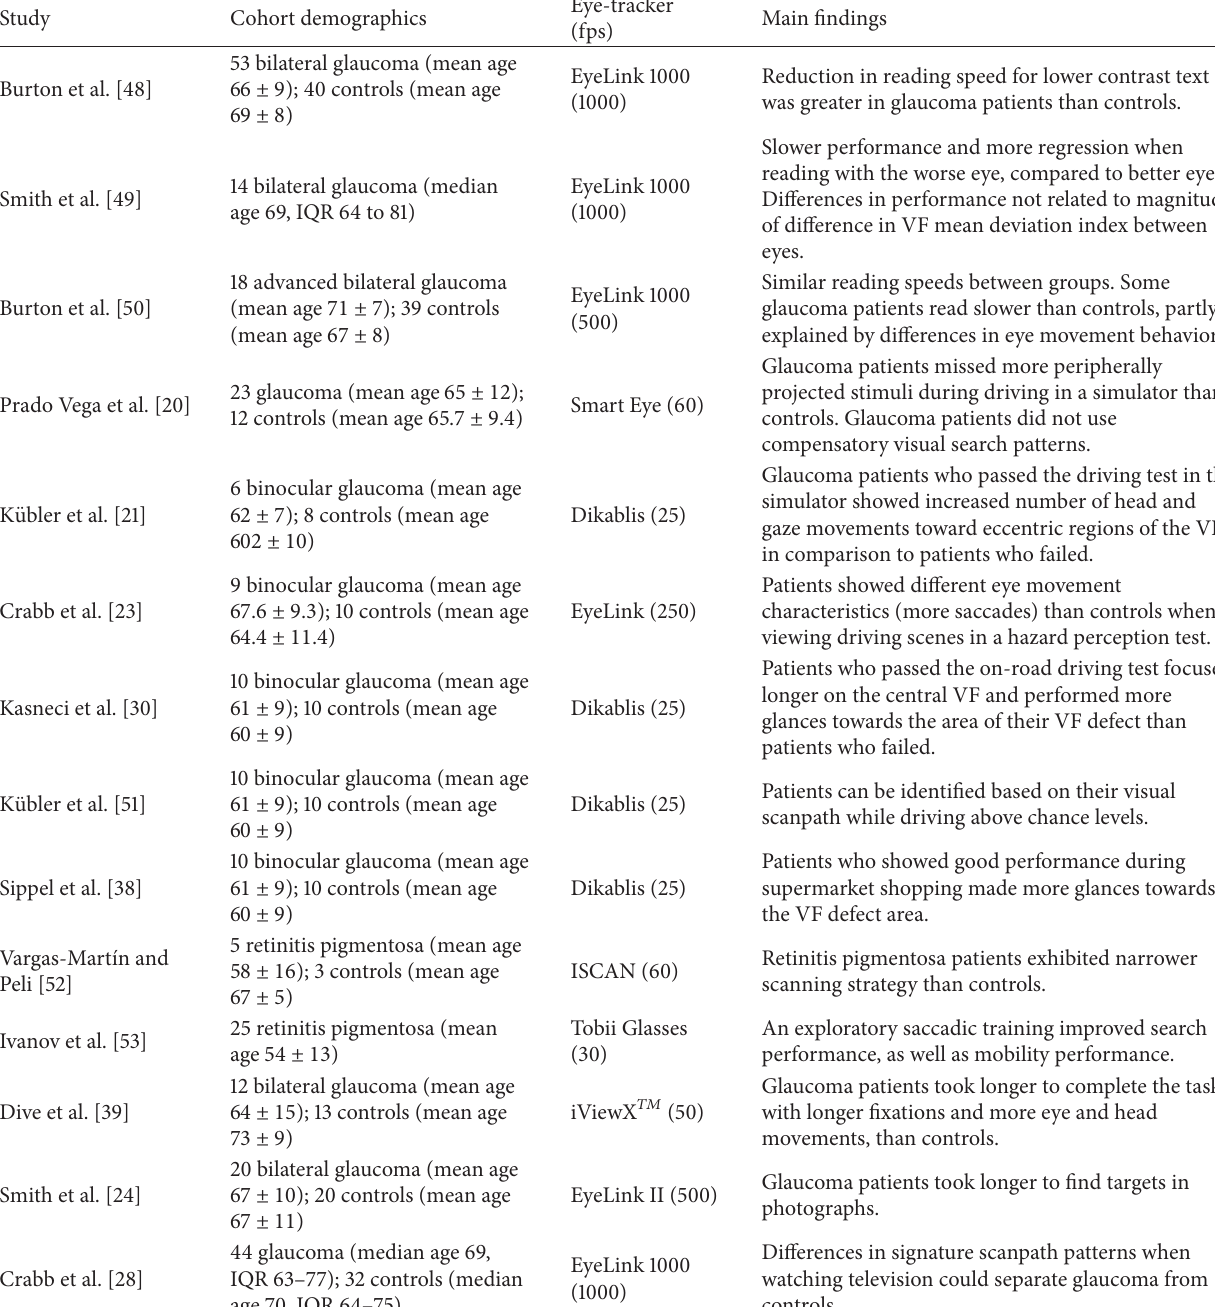
Table 1: Summary of eye-tracking studies referenced in this work with regard to their participants and eye-tracking devices. Study Cohort demographics